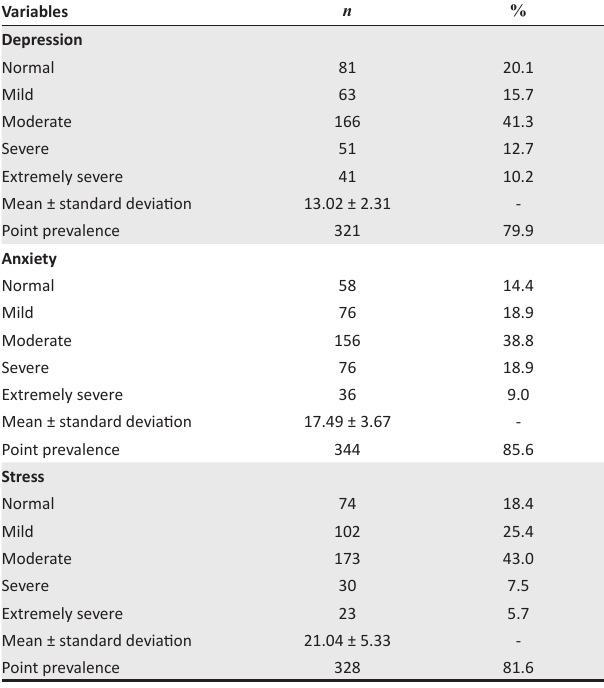
TABLE 1: Demographic characteristics of the participants ( n = 402). TABLE 2: Clinical parameters of the participants ( n = 402).